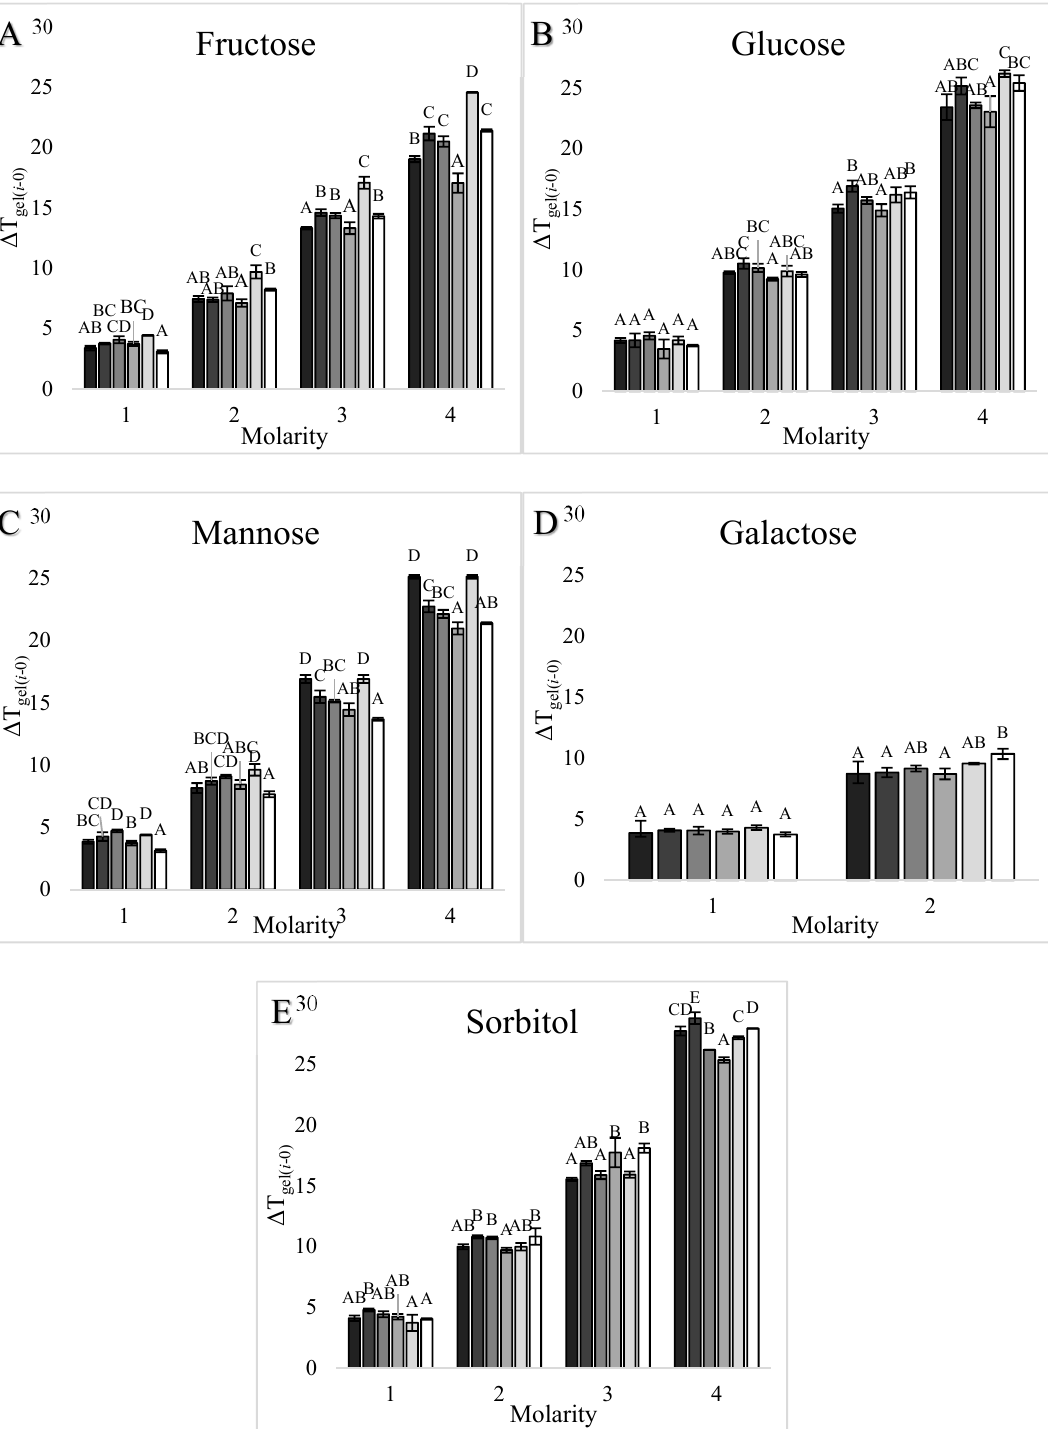
Figure 3. Effects of increasing concentrations (1 ‐ 4 M) of 6 ‐ carbon sweeteners in solution on the onset T gel of different types of starch: ( A ) fructose, ( B ) glucose, ( C ) mannose, ( D ) galactose, and ( E ) sorbitol. Starch from left to right as waxy corn ( █ ), dent corn ( █ ), HACS55 ( █ ), HACS70 ( █ ), potato ( █ ), and wheat starch ( █ ). The increase in the onset T gel in the sweetener solution compared to the onset T gel in water ( Δ T gel( i ‐ 0) ) is plotted. Error bars are 1 standard deviation, n = 3, and the capital letters indicate significant differences between T gel s.